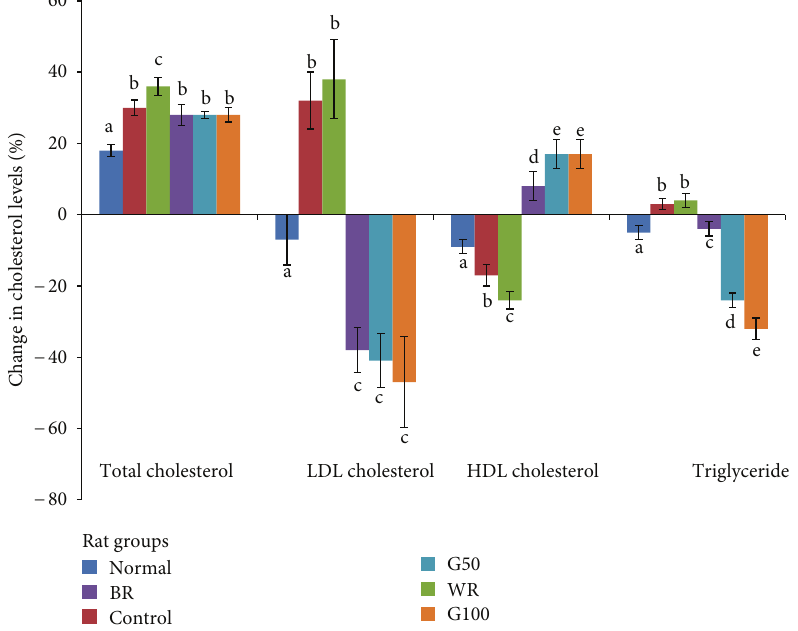
Values represent the mean SD. Values with the same letter in any given column are not signi�cantly different ( P ±